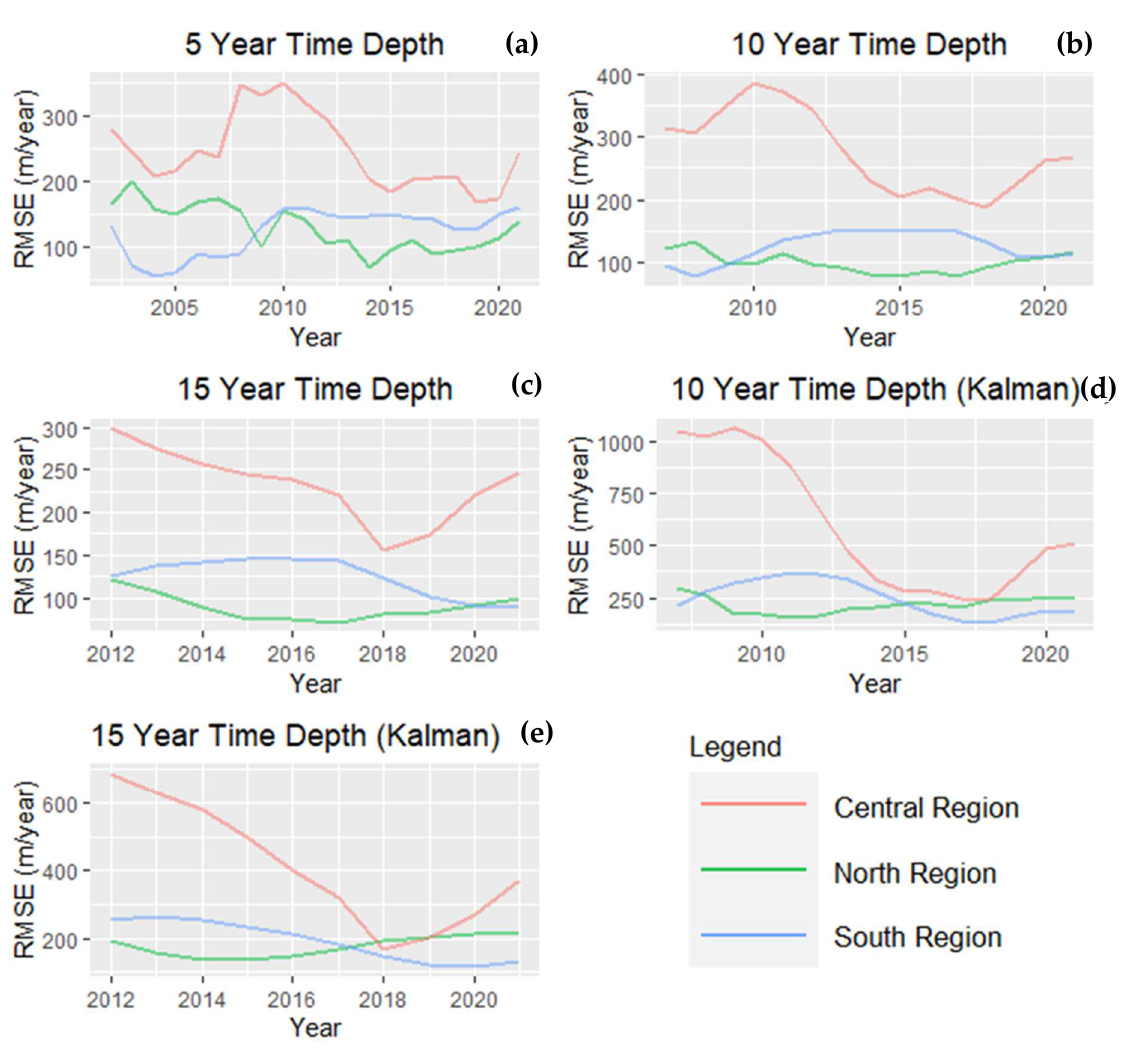
Figure 7. Variations in RMSE values of the LRR rates in predicting 10 years in the future calculated: ( a ) 5 years’ time depth, ( b ) 10 years’ time depth, ( c ) 15 years’ time depth, ( d ) 10 years’ time depth (Kalman), and ( e ) 15 years’ time depth (Kalman).